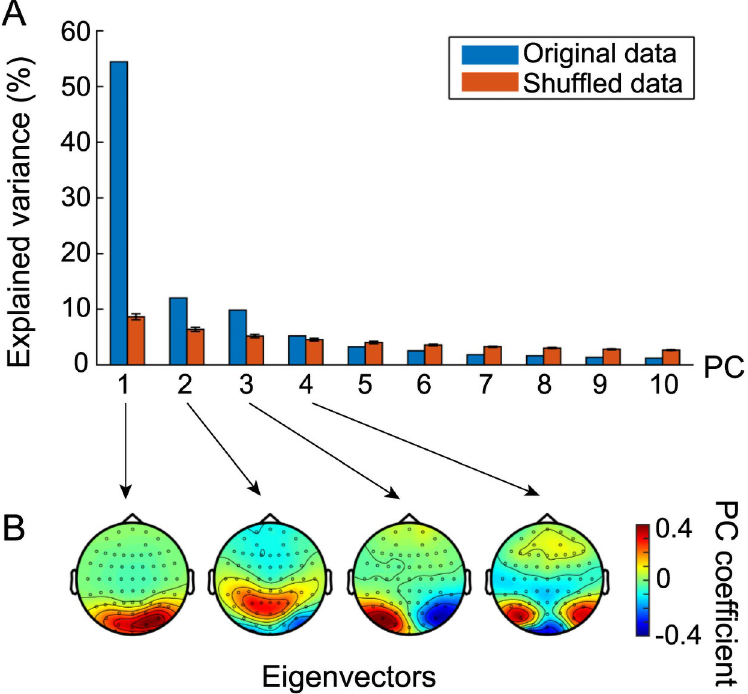
Fig 5. The four groups of consistent delta-alpha PAC states across individuals. (A) PCs of across-individual states. (B) Eigenvectors of the first four PCs. The variance explained by the first four PCs was significant, and accounted for 81.6% of total variance. The dataset used here was a set of the modified Z-scores of mean PAC strengths that were concatenated across states and